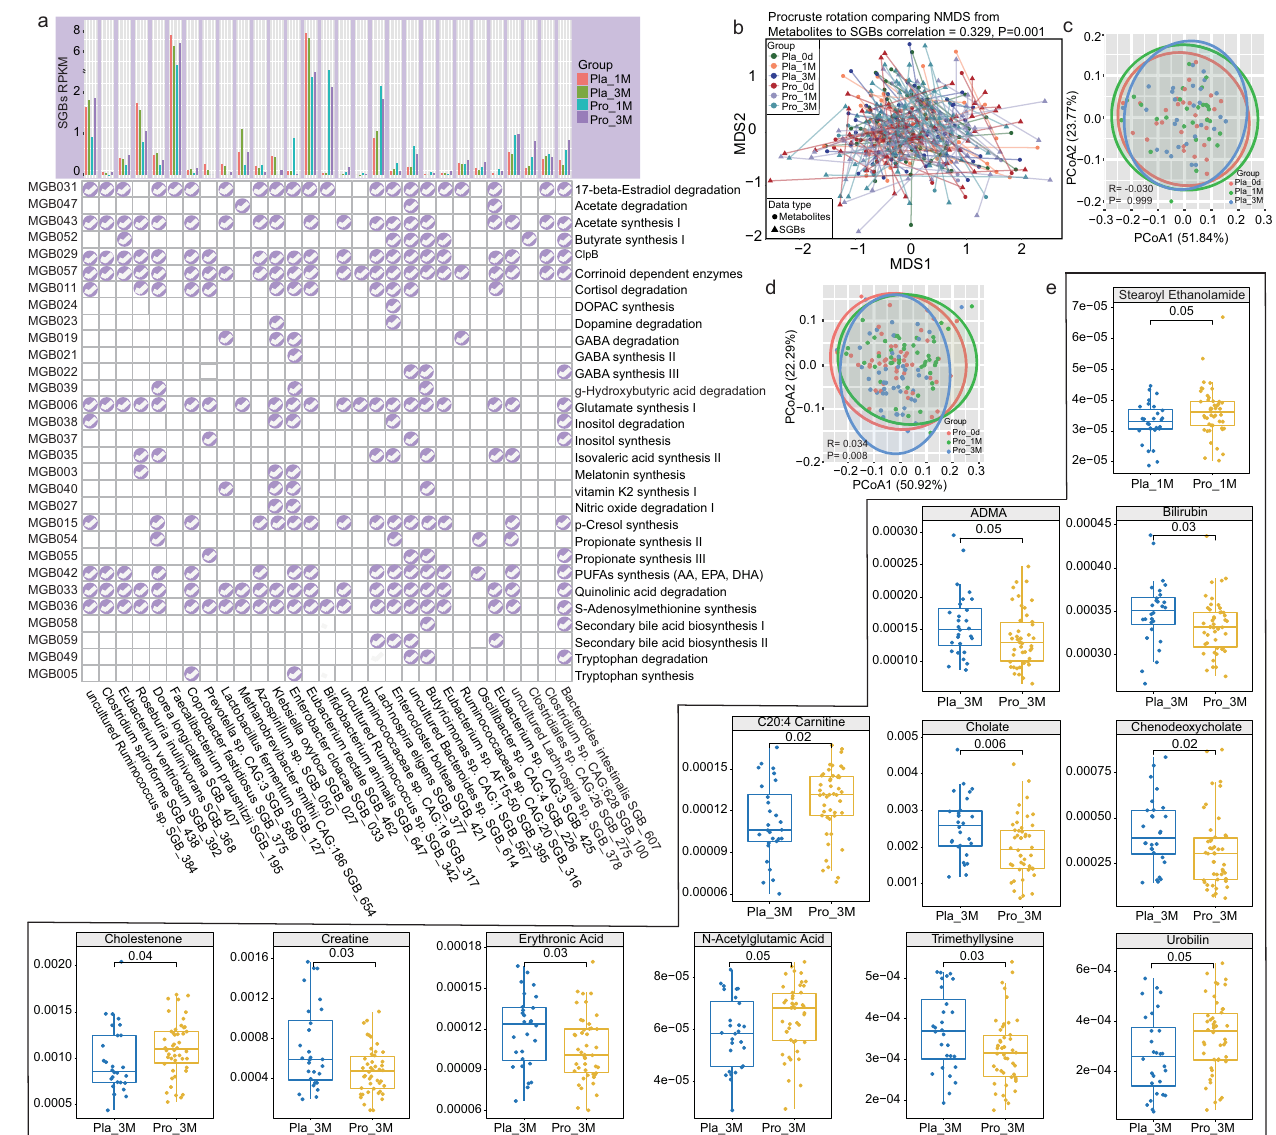
Fig. 4 Pro fi les of gut metabolic modules (GMMs) and predicted metabolites after 1- and 3-month intervention. a Distribution of selected GMMs (relating to the development, pathophysiology, and immunity related to Parkinson ’ s disease) across signi fi cant differential species-level genome bins (SGBs) between probio-M8 (Pro) and placebo (Pla) groups. b Procrustes analyses performed on the predicted microbiomes and metabolomes of the probio-M8 (Pro) and placebo (Pla) groups at day 0 (0d), 1 month (1 M), and 3 months (3 M), showing positive cooperativity between the microbiome and metabolome pro fi les (correlation = 0.329; P = 0.001). c , d Principal coordinates analysis (PCoA) score plots and Adonis test of the Probio-M8 (Pro) and placebo (Pla) groups at days 0 (0d), 1 month (1 M), and 3 months (3 M) showing changes in predicted bioactive metabolites. Symbols representing samples of individuals at different time points are shown in different colors. Signi fi cant differences between groups were evaluated by the adonis test. e Boxplots showing the contents of predicted differential bioactive metabolites that were responsive to Probio-M8 adjuvant treatment, P < 0.05 was considered statistically signi fi cant. Boxplot elements: center line, median; box limits, upper and lower quartiles; whiskers, 1.5x interquartile range; points, in Probio-M8 (baseline versus 1 M, P = 0.233, R = 0.006; baseline asymmetrical dimethylarginine (ADMA), bilirubin, cholate, cheno- versus 3 M, P = 0.003, R = 0.075; adonis test; Fig. 4d) but not deoxycholate, creatine, erythronic acid, and trimethyllysine ( P ≤ placebo group (Fig. 4c). 0.05 in all cases, Fig. 4e and Supplementary Table 8) dropped To pinpoint the spectrum of probiotic-regulated gut bioactive signi fi cantly in Probio-M8 group compared with the placebo metabolites, the differential predicted metabolites between the group, and opposite trends were observed in C20:4 carnitine, Probio-M8 group and placebo group at 1 M and 3 M were cholestenone, N -acetylglutamic acid, and urobilin. identi fi ed. Only one differential predicted metabolite was identi fi ed after one month of treatment, which was stearoyl Probio-M8 affected serum SCFAs and neurotransmitters in ethanolamide; signi fi cantly more stearoyl ethanolamide ( P = 0.05) patients with PD was found in the probiotic group than placebo group at 1 M. More To con fi rm the results generated by MelonnPan and Procrustes obvious changes were detected at 3 M, which were observed in 11 predicted metabolites. At 3 M, the predicted abundances of analyses, GC-MS/MS was used to determine the levels of serum